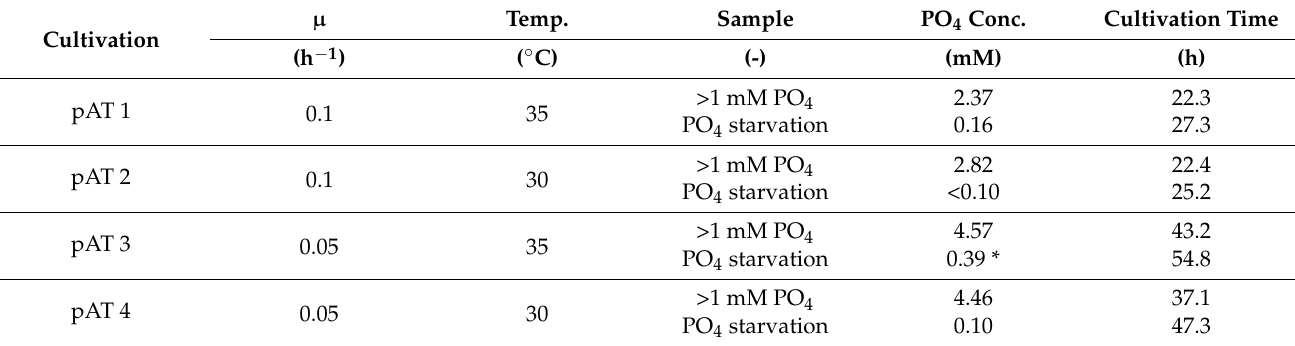
Table 3. Impact of cultivation conditions on cultivation times for pAT cultivations. µ Cultivation